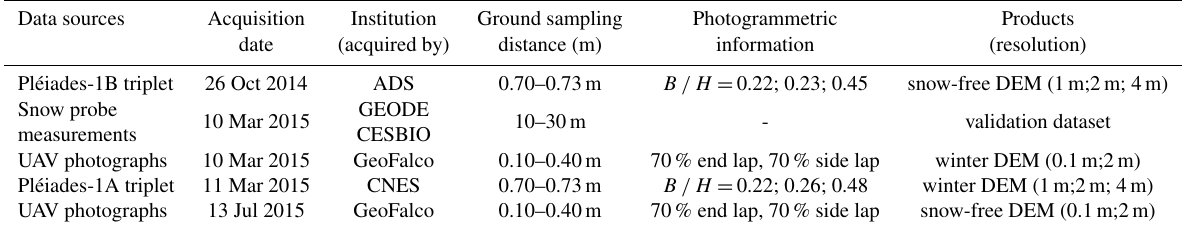
Table 1. Data sources and description. ADS means Airbus Defence and Space. GEODE and CESBIO are both laboratories of the Toulouse University (France). GeoFalco is a French start-up specialized in UAV data acquisition and